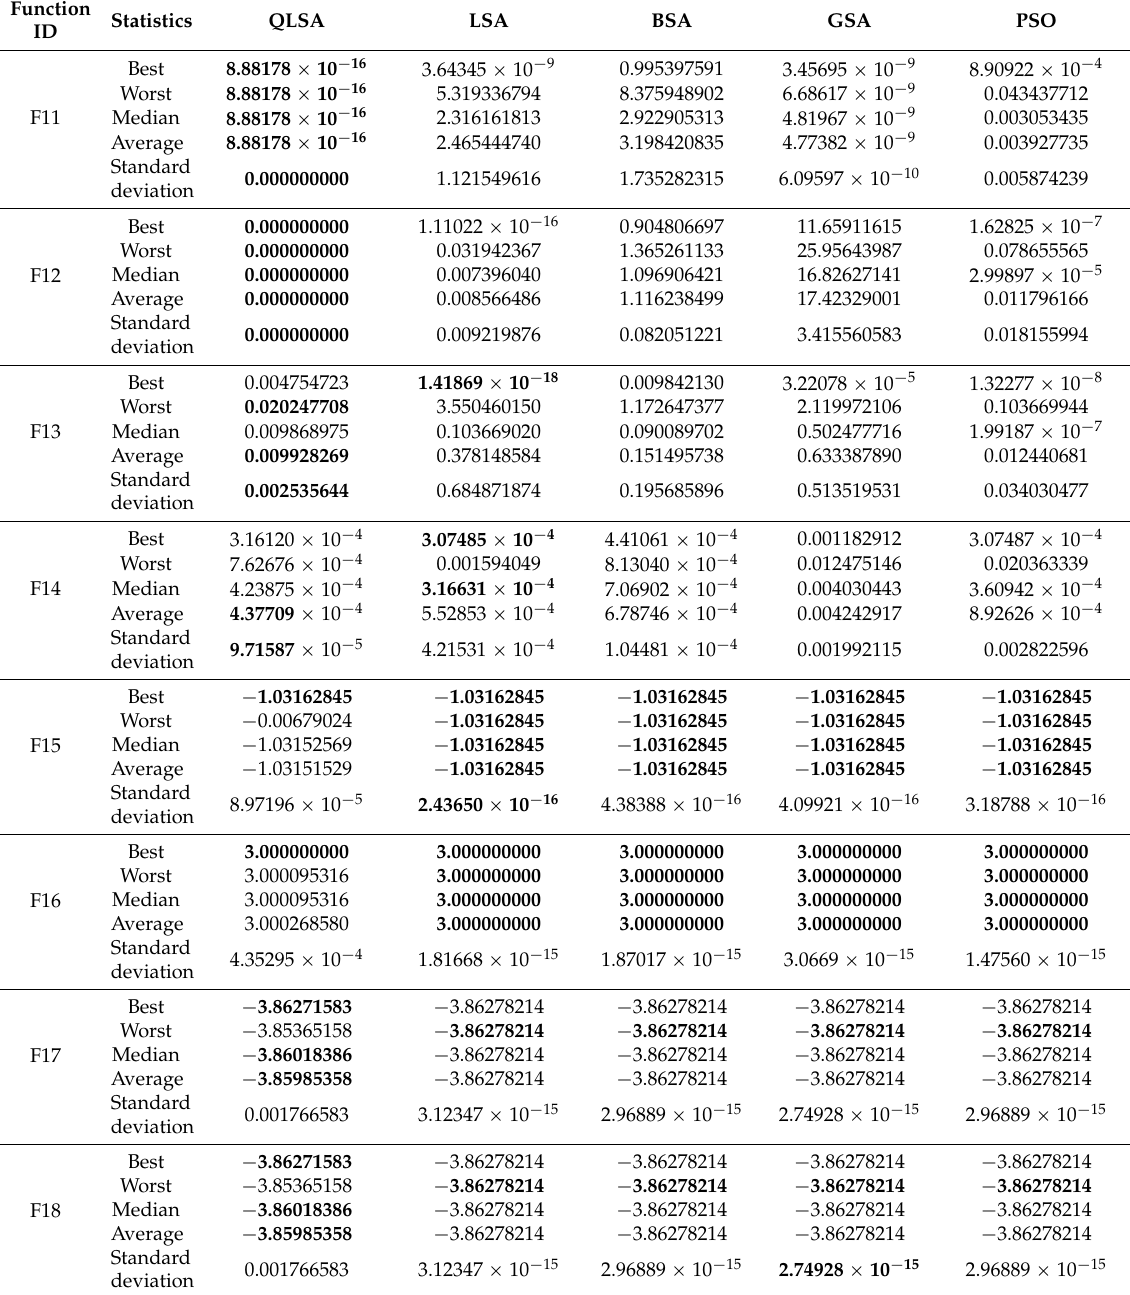
Table 10. Test 3 global optimization results for benchmark functions in Table